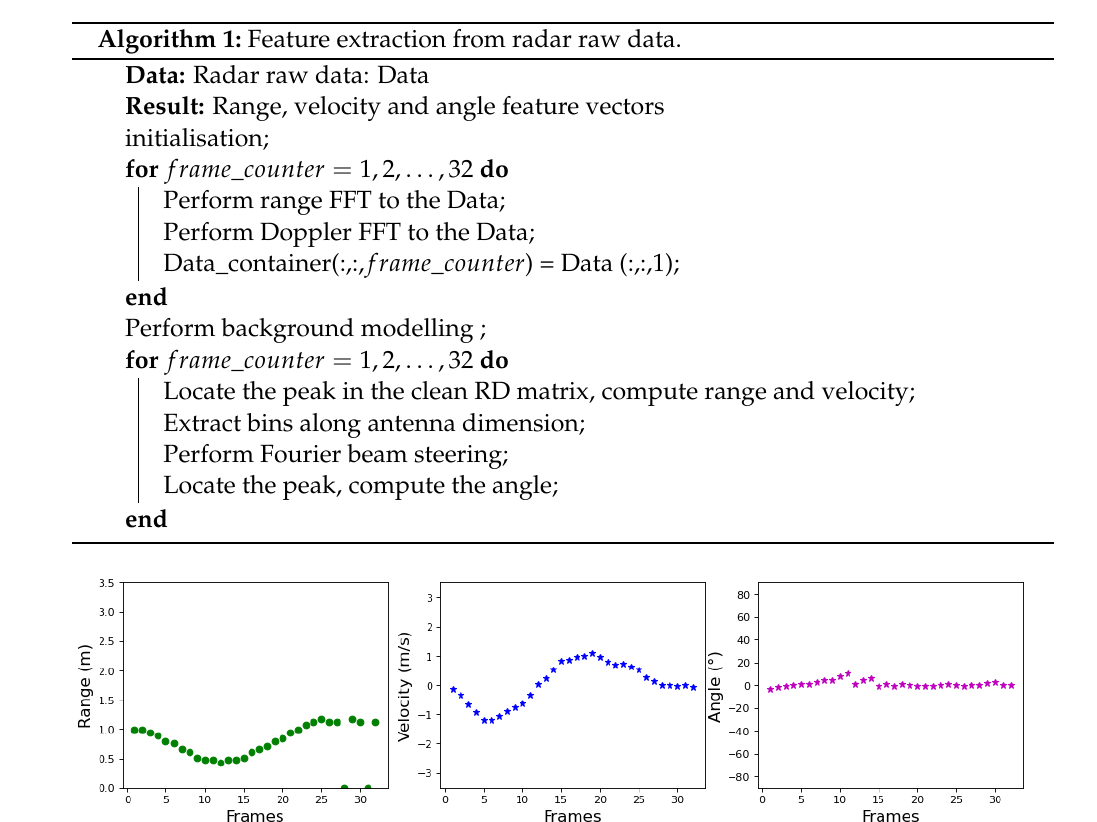
Figure 5. An example of gesture “push